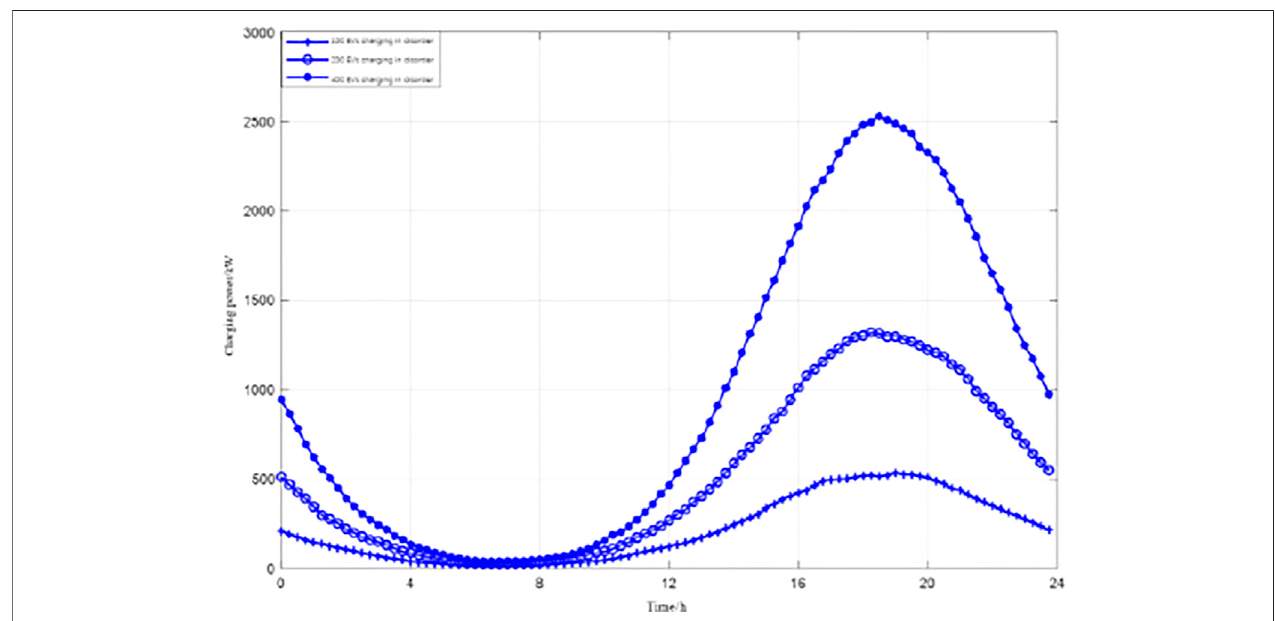
FIGURE 4 | Monte Carlo simulation of electric vehicle disorderly